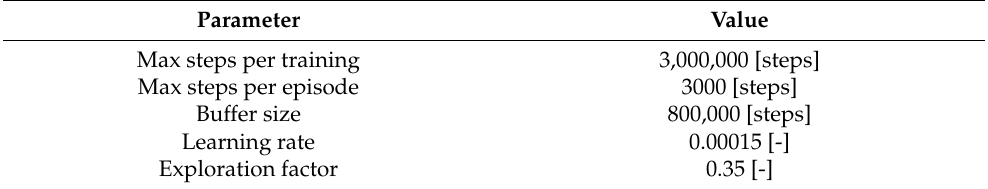
Table 3. Hyperparameters of the DQN agent.